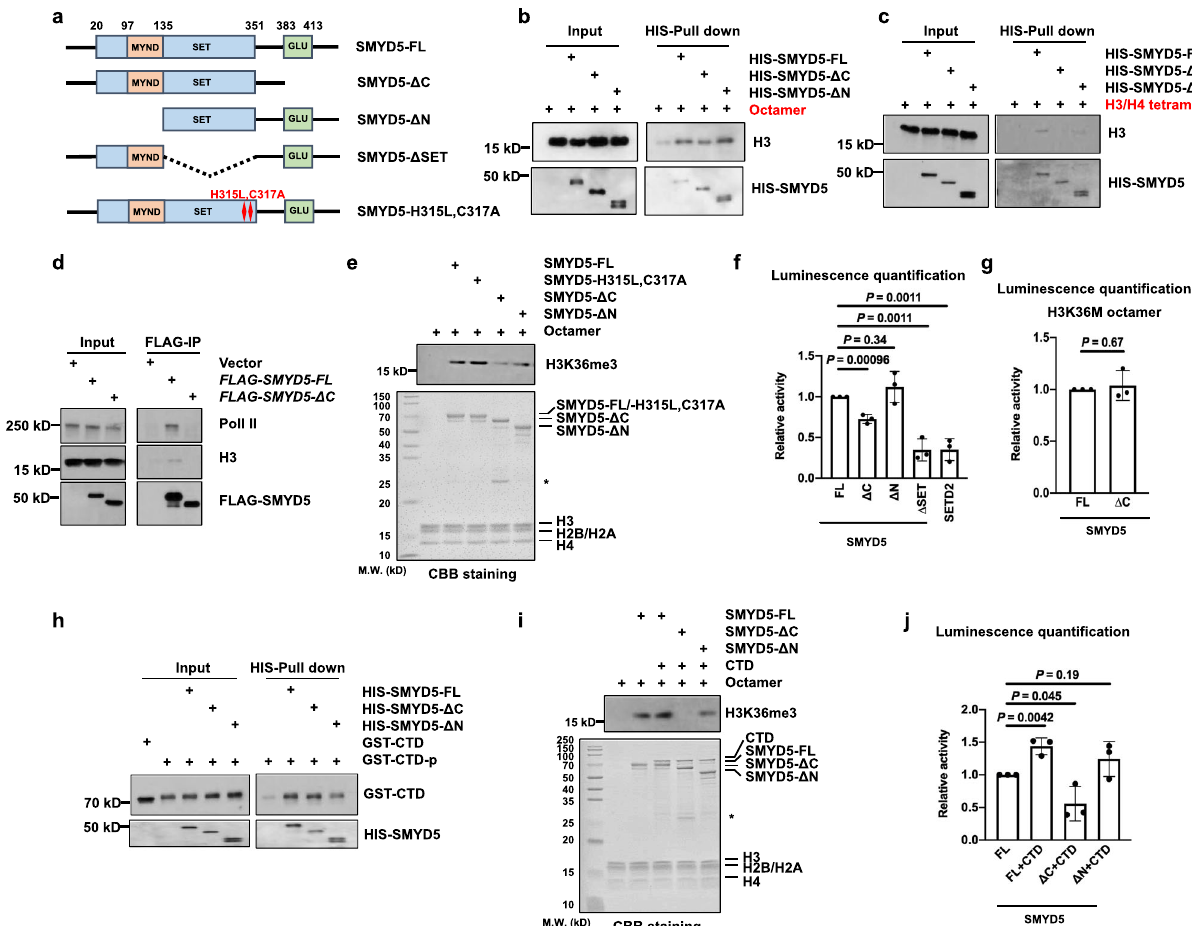
Fig. 5 The methyltransferase activity of SMYD5 is regulated by its C-terminal domain. a Schema showing the functional domains and mutations of SMYD5. b Deletion of the C-terminal domain of SMYD5 reduced its interaction with octamers. Recombinant HIS tagged SMYD5 and SMYD5 mutants were incubated with an equal amount of histone core octamers. NI-NTA Se fl nose Resin beads were used to pull down SMYD5. Two independent experiments were performed. c Same as in ( b ), except H3/H4 tetramer was used to incubate with WT and mutant SMYD5. Two independent experiments were performed. d Removal of the C-terminal domain repressed the interactions among SMYD5, Pol II, and H3. FLAG-tagged SMYD5 full length (FL) or C-terminal deletion ( Δ C) over-expressed HEK 293 T were subjected to FLAG IP. Proteins from input and IP samples were analyzed by Western blotting using the indicated antibodies. HEK 293 T transfected with empty vectors were used as the negative controls. Two independent experiments were performed. e HMT assays of full length SMYD5 and mutant SMYD5 against octamer substrates. Upper panel, H3K36me3 was detected by Western blotting. Lower panel, input by Coomassie Brilliant Blue (CBB) staining. Each assay was repeated at least three times with similar results. Asterisk indicates non-speci fi c proteins. f End-point HMT assays of full length SMYD5 and mutant SMYD5 against core octamers. After the reaction, SAM was transferred to SAH which was detected by the MTase-Glo ™ assay. Each assay was repeated at least three times with similar results. N = 3 independent experiments. Data are mean ± SD. P values were calculated by one-way ANOVA. g End-point HMT assays of full length and C-terminal deleted SMYD5 against H3K36M mutant octamers. After the reaction, SAM was transferred to SAH which was detected by the MTase-Glo ™ assay. N = 3 independent experiments. Data are mean ± SD. P values were calculated by one-way ANOVA. h N-terminal domain is important for the interaction between SMYD5 and phosphorylated Pol II CTD. GST tagged Pol II CTD was puri fi ed and then phosphorylated by the CDK7-Cyclin H complex. Recombinant HIS-tagged full length and mutant SMYD5 were puri fi ed and incubated with phosphorylated Pol II CTD, respectively. Ni-NTA Se fl nose Resin beads were used to pull down SMYD5. The input and beads-bound proteins were analyzed by Western blotting using the indicated antibodies. Unphosphorylated Pol II CTD was used as the negative control for the mobility shift of phosphorylated Pol II CTD. CTD, Pol II CTD. CTD-p, phosphorylated Pol II CTD. Two independent experiments were performed. i HMT assays of full length SMYD5 and mutant SMYD5 against octamer substrates in the presence of Pol II CTD. Upper panel, H3K36me3 was detected by Western blotting. Lower panel, the input of the reactions was shown by Coomassie Brilliant Blue (CBB) staining. Each assay was repeated at least three times with similar results. Star indicated the non-speci fi c proteins. CTD, Pol II CTD. Two independent experiments were performed. j End-point HMT assays of full length SMYD5 and mutant SMYD5 against octamer substrates in the presence of Pol II CTD. After the reaction, SAM was transferred to SAH which was detected by the MTase-Glo ™ assay. N = 3 independent experiments. Data are mean ± SD. P values were calculated by one-way ANOVA. CTD, Pol II CTD. Source data are provided as a Source Data fi mutant protein to promoters. Furthermore, enrichment of FLAG- reconstituted cells (Fig. 6H and Supplementary Fig. 6a – c). To tagged SMYD5 and H3K36me3 was revealed at three representa- evaluate how H3K36me3 is restored by reexpression of Smyd5 , we tive chromatin loci (Fig. 6g). Enrichment of Pol II and plotted the overexpressed SMYD5 signals and alterations in H4K20me3 at promoters was not altered in Smyd5 KO or H3K36me3 at promoters which overlapped with the H3K36me3